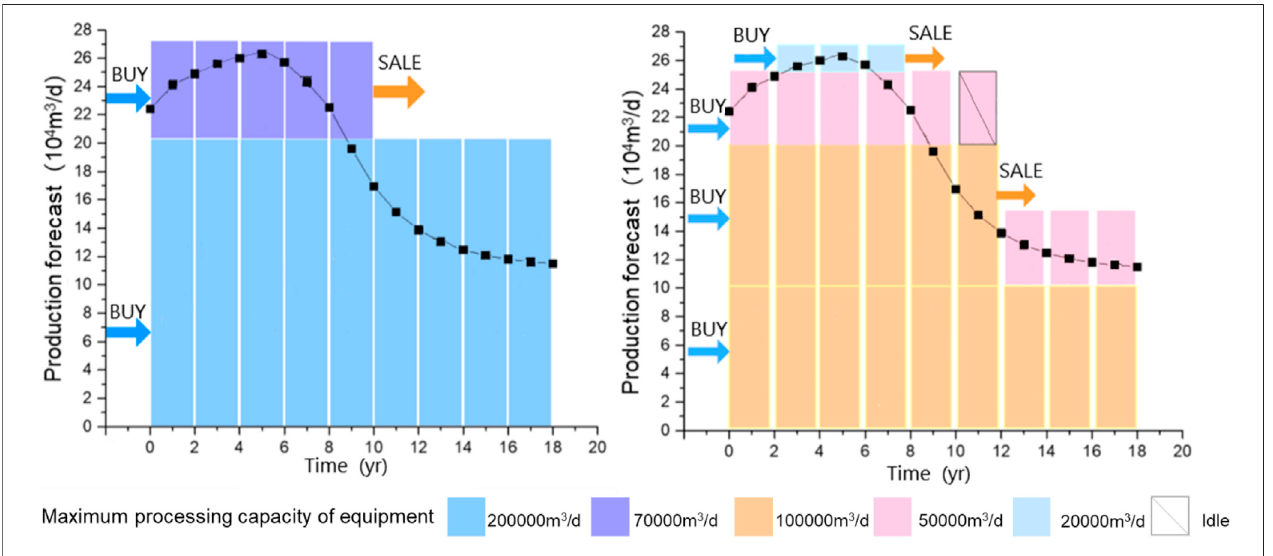
FIGURE 1 | Schematic diagram of the use scheme for different series of modular